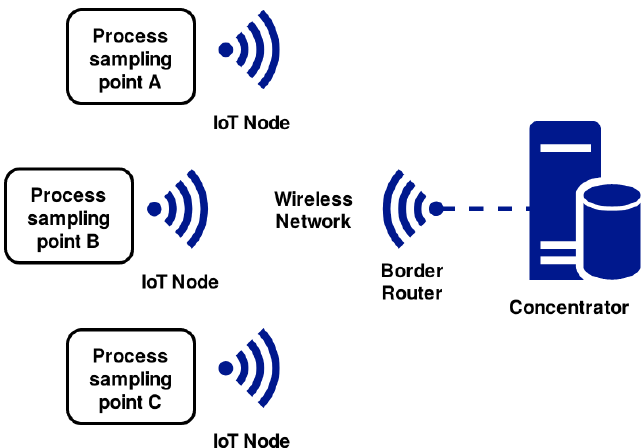
Figure 3. Network Architecture I4.0 Pilot